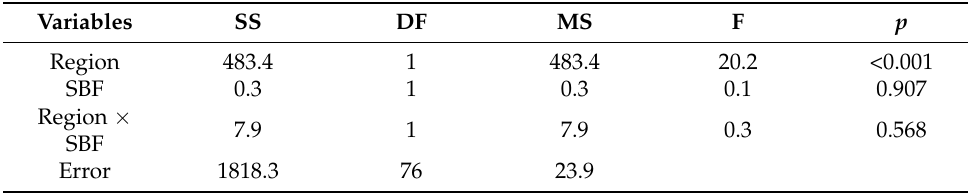
Table 3. Two-way analysis of variance result for overall stability index